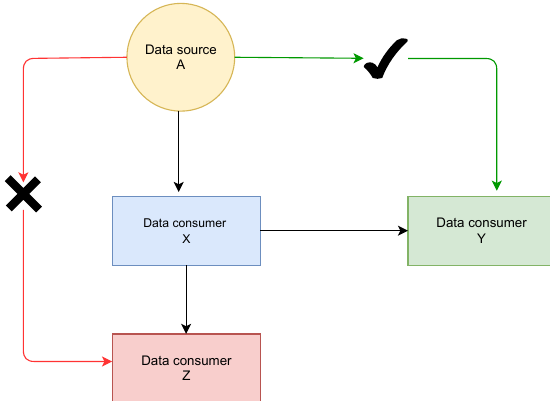
Figure 5. Subjective interactions between a data source and three data